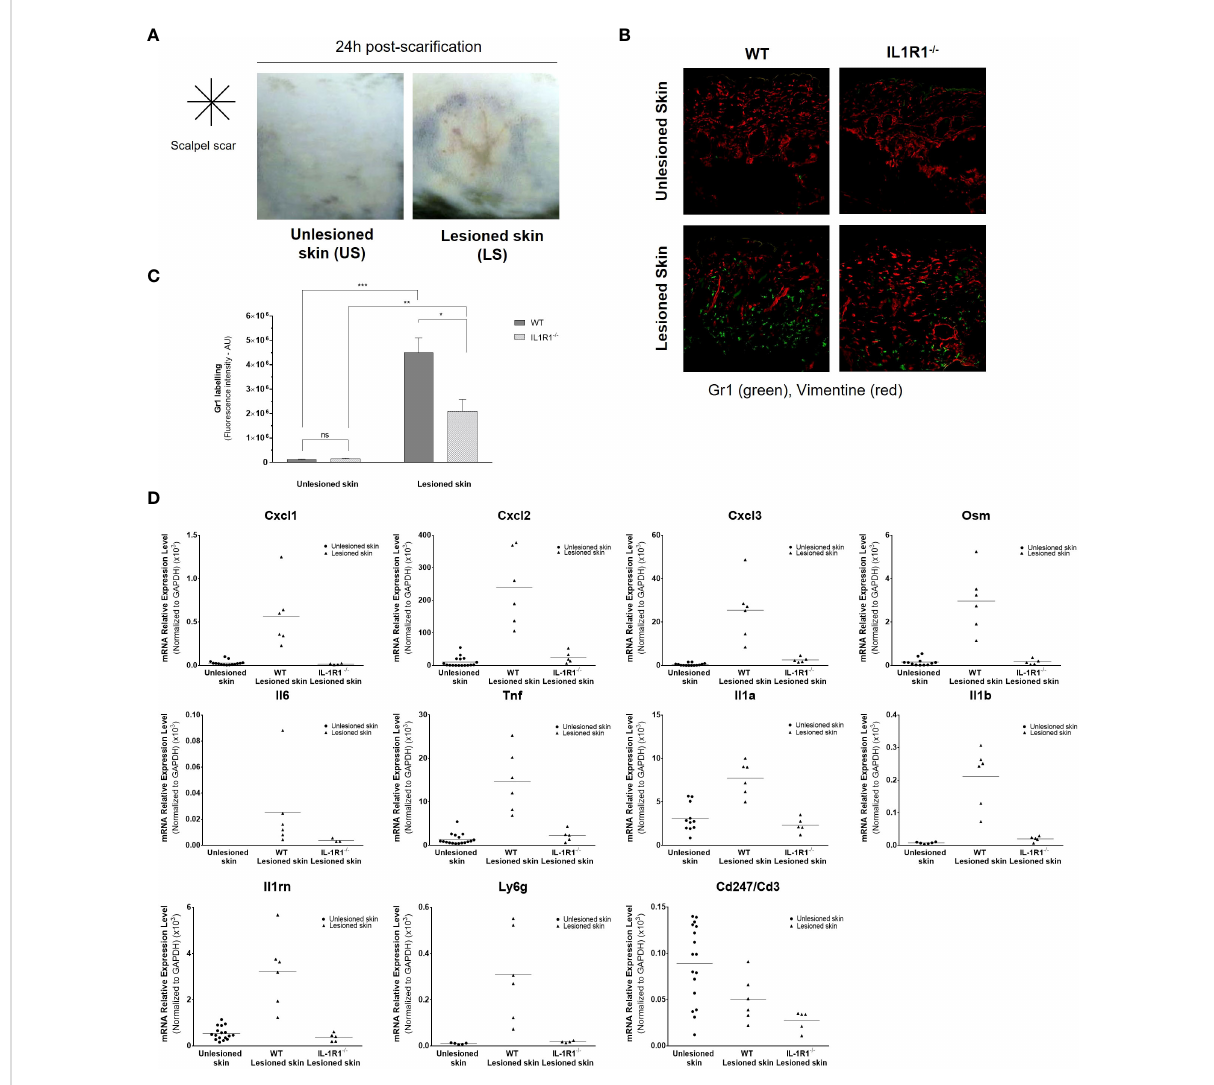
FIGURE 7 Aseptic epidermal lesion induces skin in fi ltration of neutrophils in an IL-1-dependent manner. The epidermis of the back skin of WT and IL-1R1- de fi cient (IL-1R1 -/- ) mice was scari fi ed in aseptic conditions using a sterile scalpel. Representative pictures of mouse unlesioned skin and the lesioned back skin of mice 24 h after a cross-shaped scari fi cation (A) . Immuno fl uorescence staining of Gr1-positive neutrophils (in green) and the mesenchymal marker vimentin (in red), in skin sections of unlesioned and lesioned skins of WT and IL-1R1-de fi cient mice (B) . Quantitative analysis of Gr1-speci fi c fl uorescent labelling in unlesioned and lesioned skin sections of WT and IL-1R1-de fi cient mice (C) . Transcriptional analysis by RT-qPCR after mRNA extraction from lesioned back skins of WT and IL-1R1-KO mice and unlesioned skins (both from WT and IL- 1R1-KO mice) 24 h after scari fi cation (D) . The expression of CXCL1 , CXCL2 , CXCL3, OSM, IL-6, TNF a , IL-1 a , IL-1 b , IL-1RA, Ly6G and CD3 z (CD247) was analyzed and expressed as mean ± SEM relative expression to the housekeeping gene Gapdh . * P < 0.05, ** P < 0.01, *** P < 0.001 using the Mann & Whitney ’ s